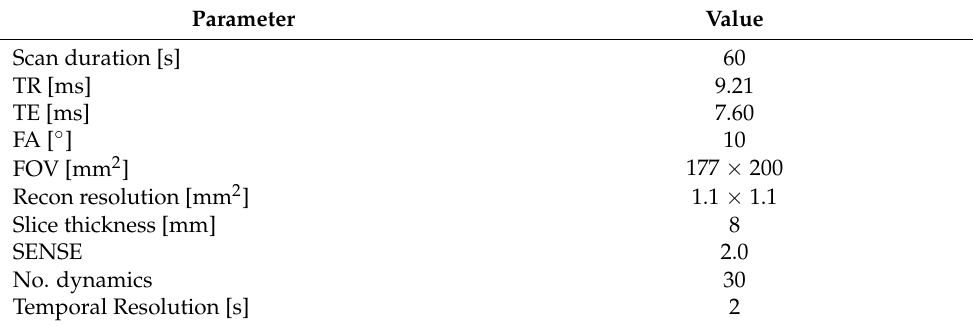
Table 1. MRI scanner